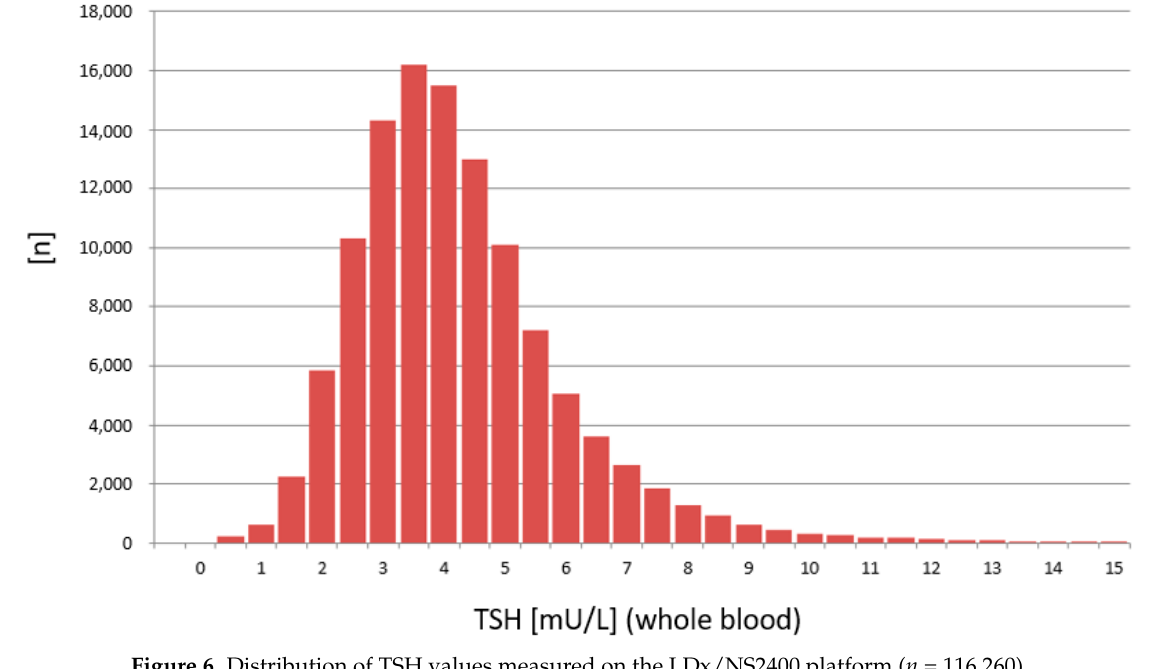
Figure 5. Distribution of TSH values measured on the PE/GSP platform ( n = 748,180).